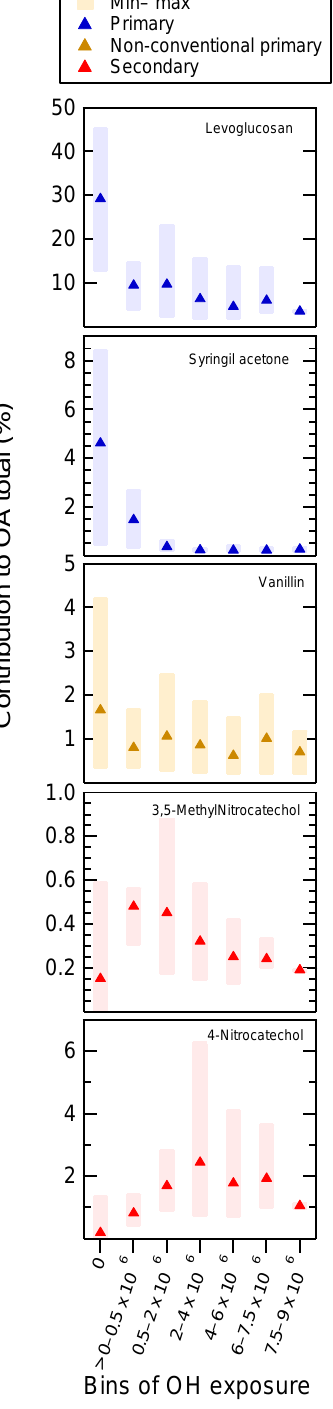
Figure 8. Evolution of the contribution of several markers to the OA (t) mass concentration at different time points in the photo- oxidation process. The marker represents the mean value over all experiments within a specific range of integrated OH exposure. The box includes the minimum and maximum within the same